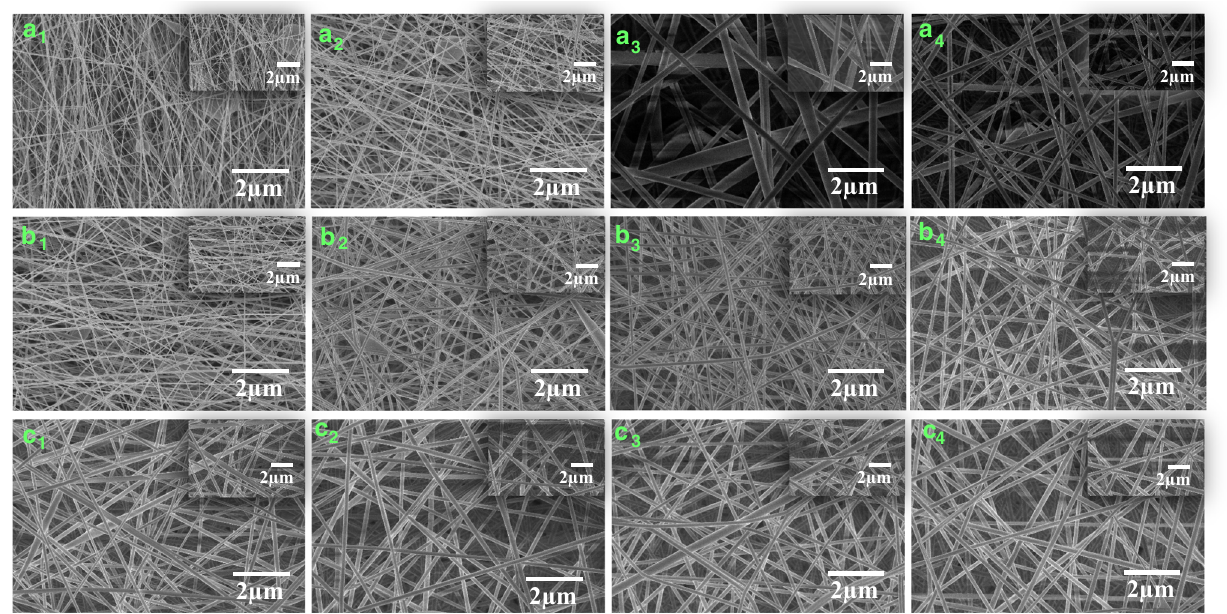
Fig. 3 SEM images of electrospun fibers:. a1–a4 10% PAN inner layer 6–12% PVDF, b1–b4 outer layer 12% PAN inner layer 6–12% PVDF, c1– c4 outer layer 14% PAN inner layer 6–12% PVDF